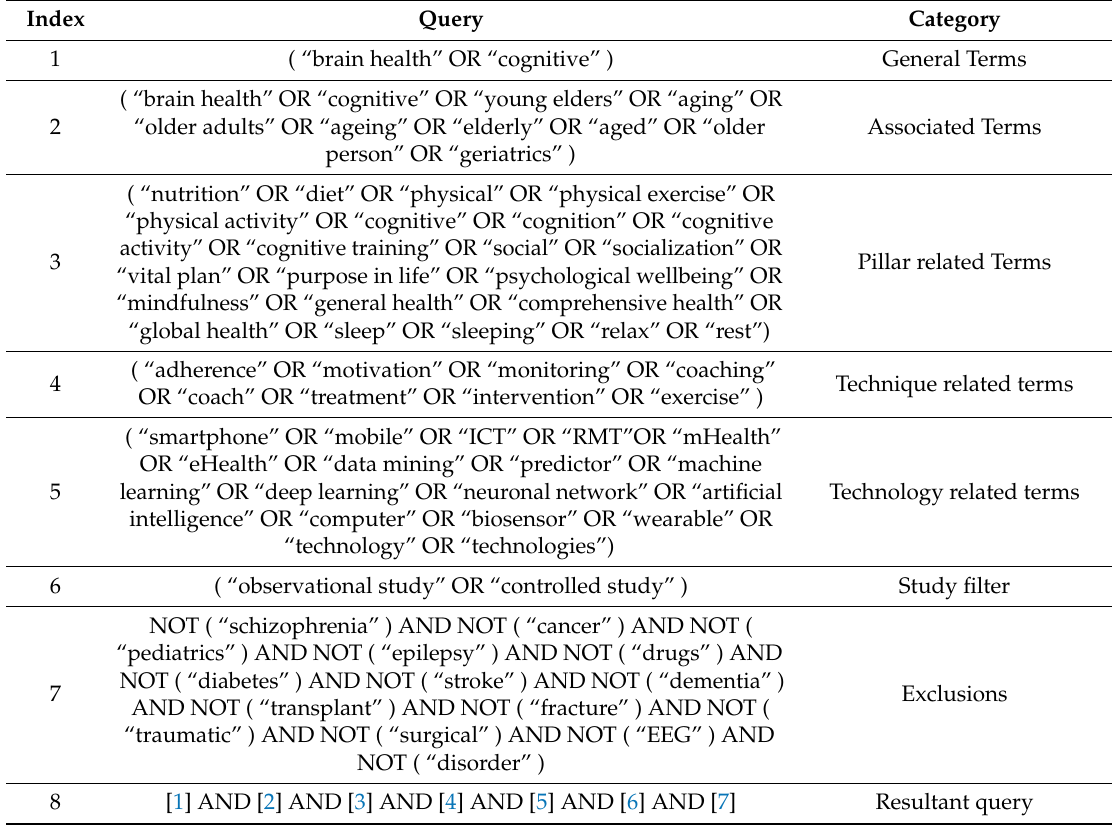
Table A1. Indexed query formation